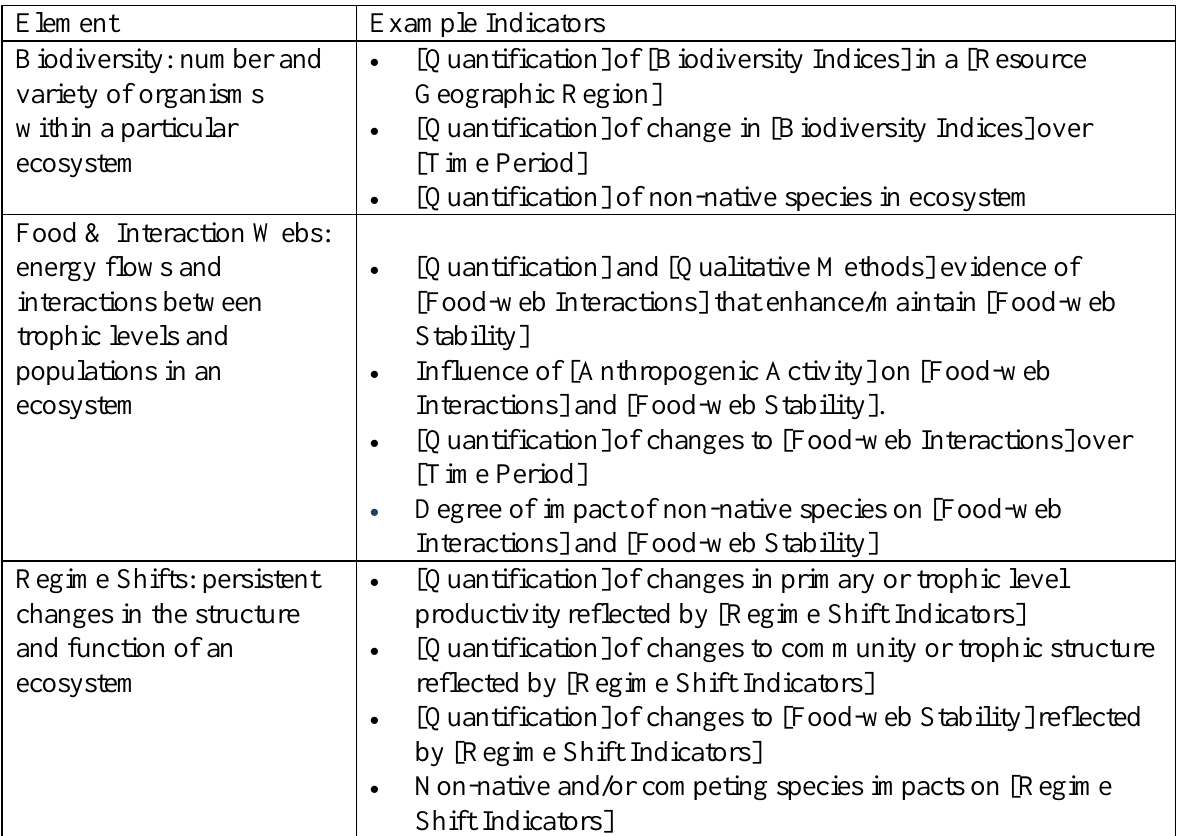
Table A1.6: Ecosystem Structure & Functionality Dimension – Example Indicators Element Example